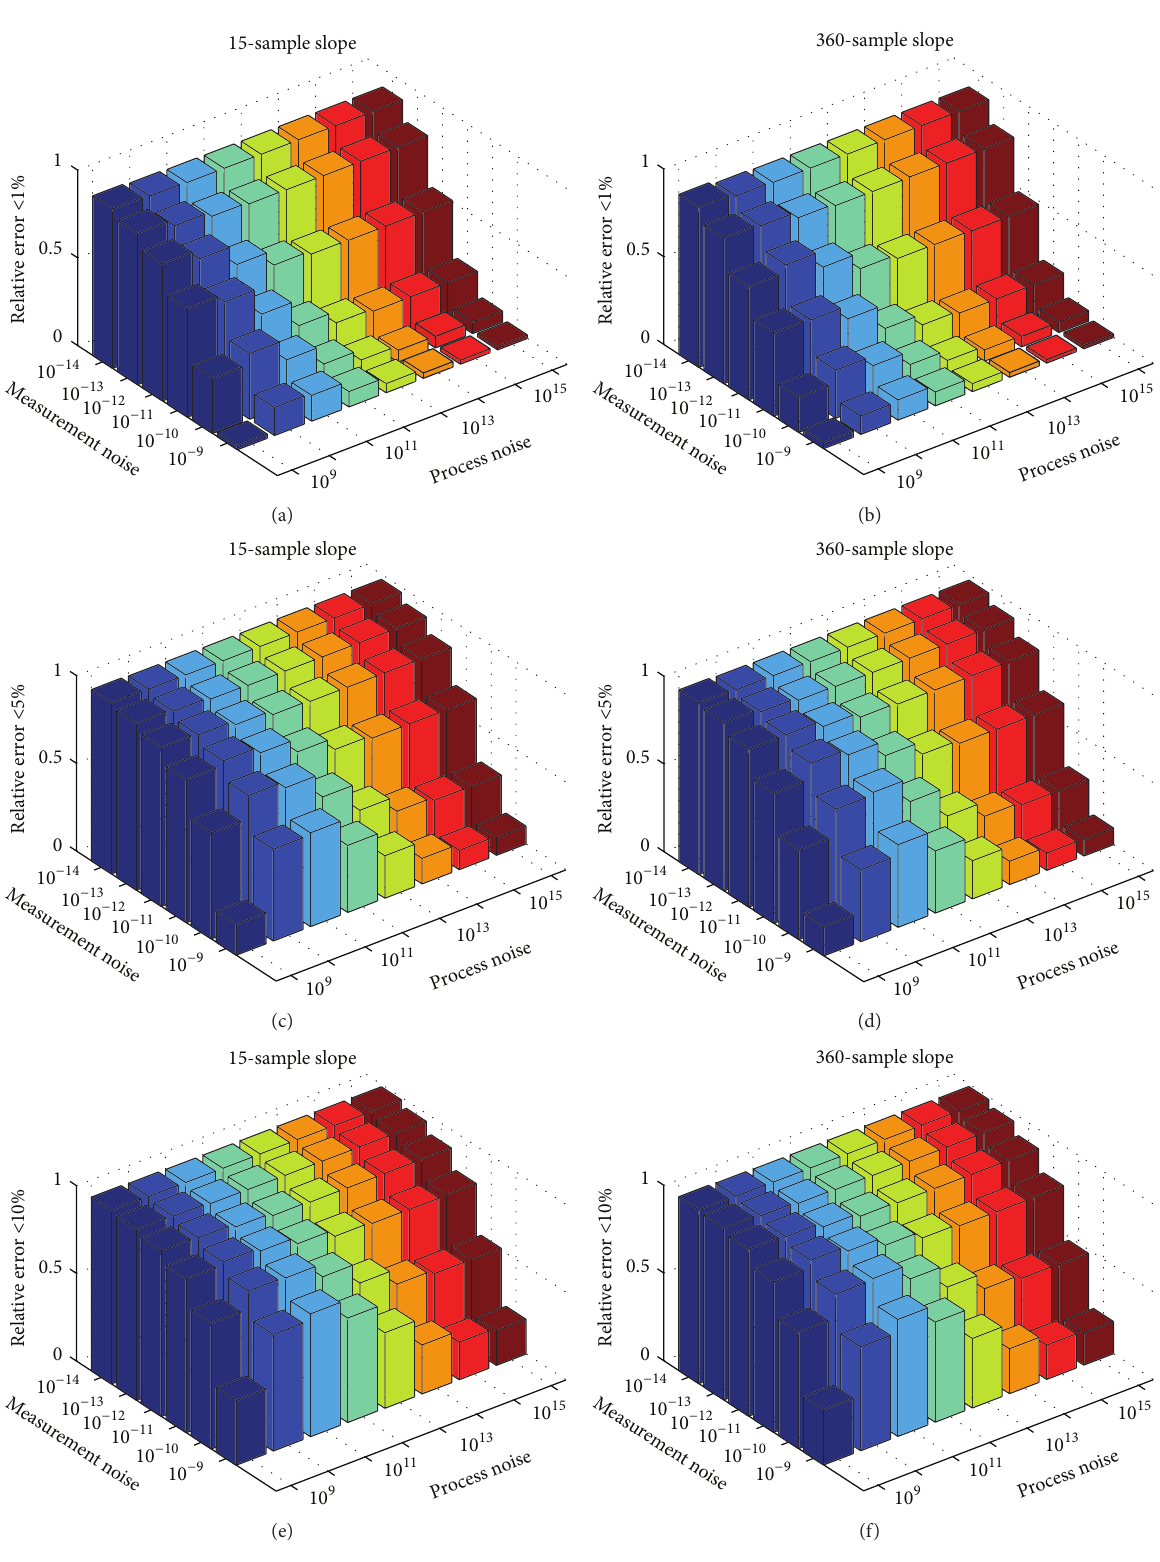
Figure 3: Percentage of relative errors that are below different thresholds 𝜃 for fast AB variations (a, c, and e) and slow AB variations (b, d, and f). 𝜃 = 1 % in (a) and (b), 𝜃 = 5 % in (c) and (d), and 𝜃 = 10 % in (e) and